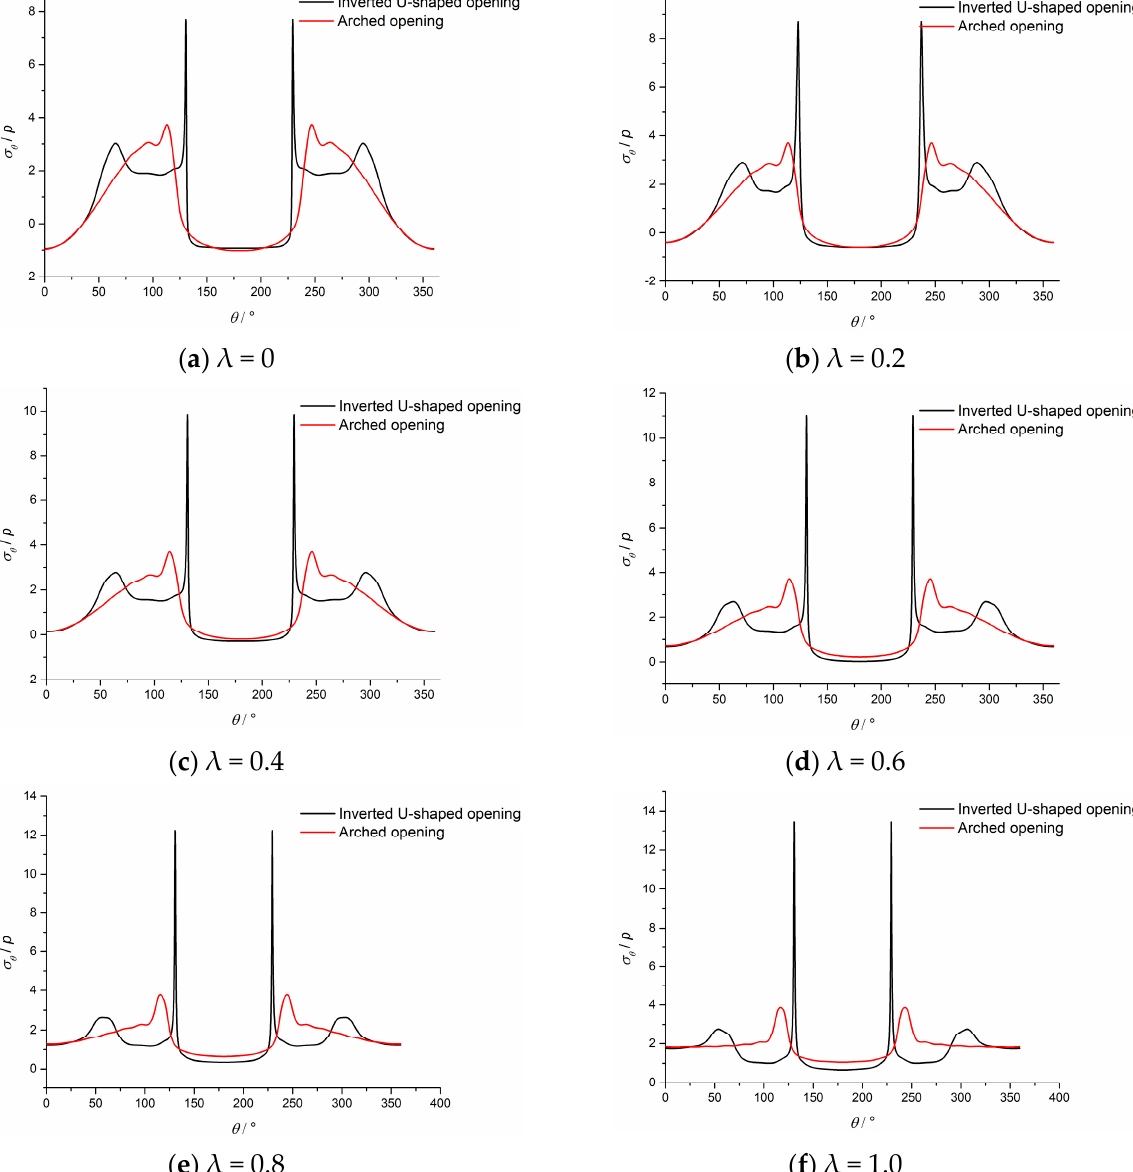
Figure 9. Analytical solution of hoop stress around openings with different λ .